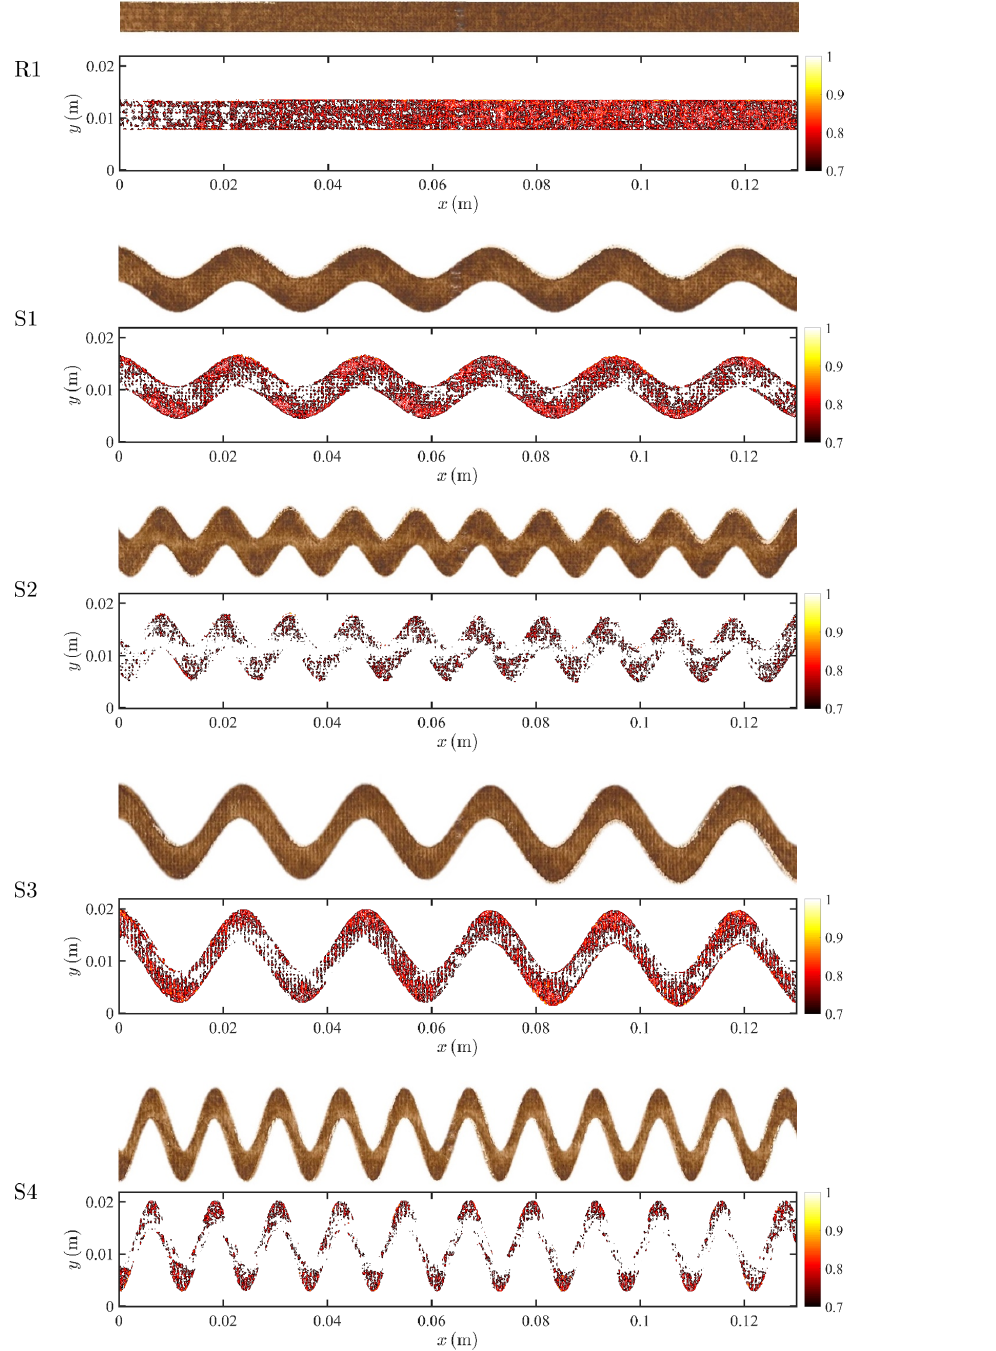
Figure 4. Images of the fouled membrane at the end of each experiment (top brown images) and digitalized fouling patterns (bottom red images) based on the gray scale of the experimental results. The threshold of all the images is set to be α =